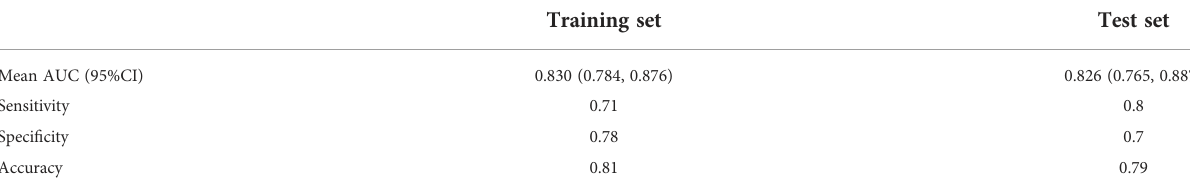
AUC, the area under the mean receiver operating characteristic